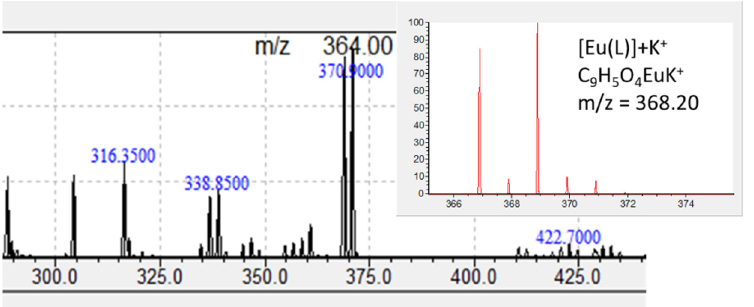
Figure 7. Experimental and theoretical (inset) ESI-MS spectra of the [Eu(L)]+K + species in the Eu 3+ /CFA system in aqueous solution.